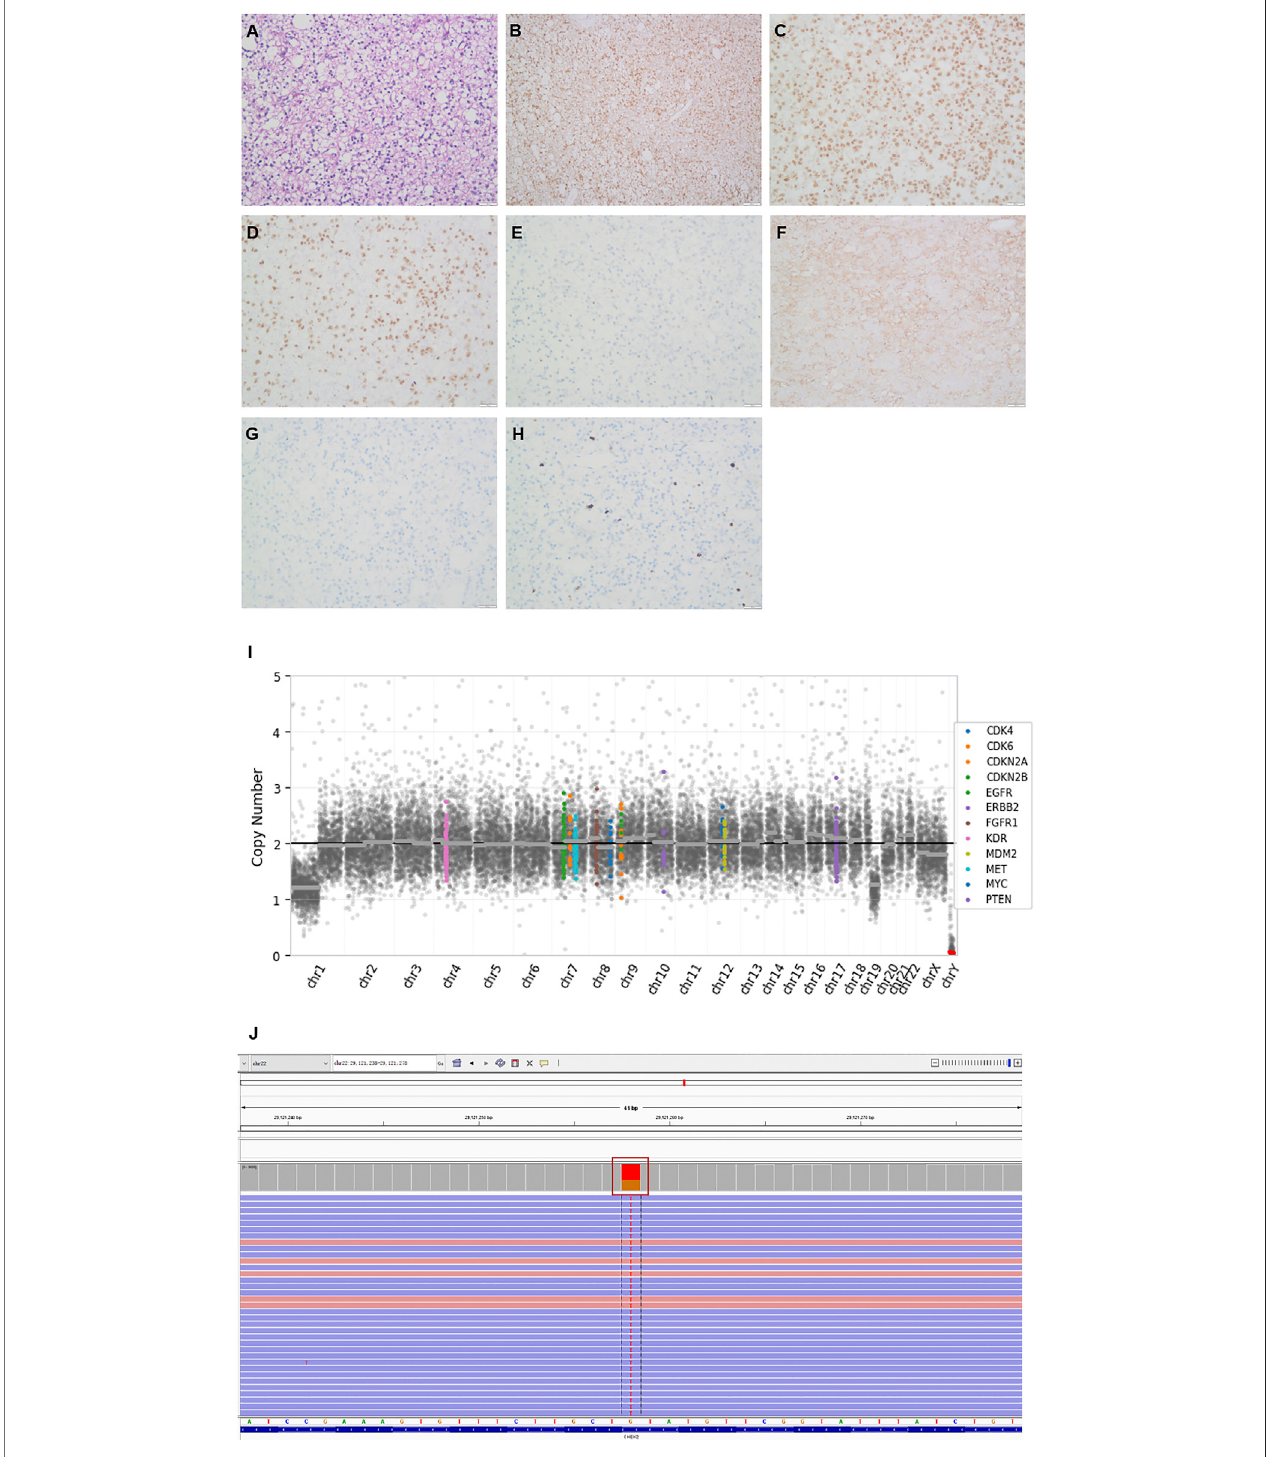
FIGURE 1 | Histopathologic stains from the postoperative right frontal lobe (A – H) , 1P19Q chromosomal combination deletion (I) and the Integrative Genomics Viewer snapshot of CHEK2 p.R137* (J) . (A) hematoxylin and eosin. (B) IDH. (C) ATRX. (D) Olig2. (E) P53. (F) GFAP. (G) NeuN. (H) Ki67. (200×).